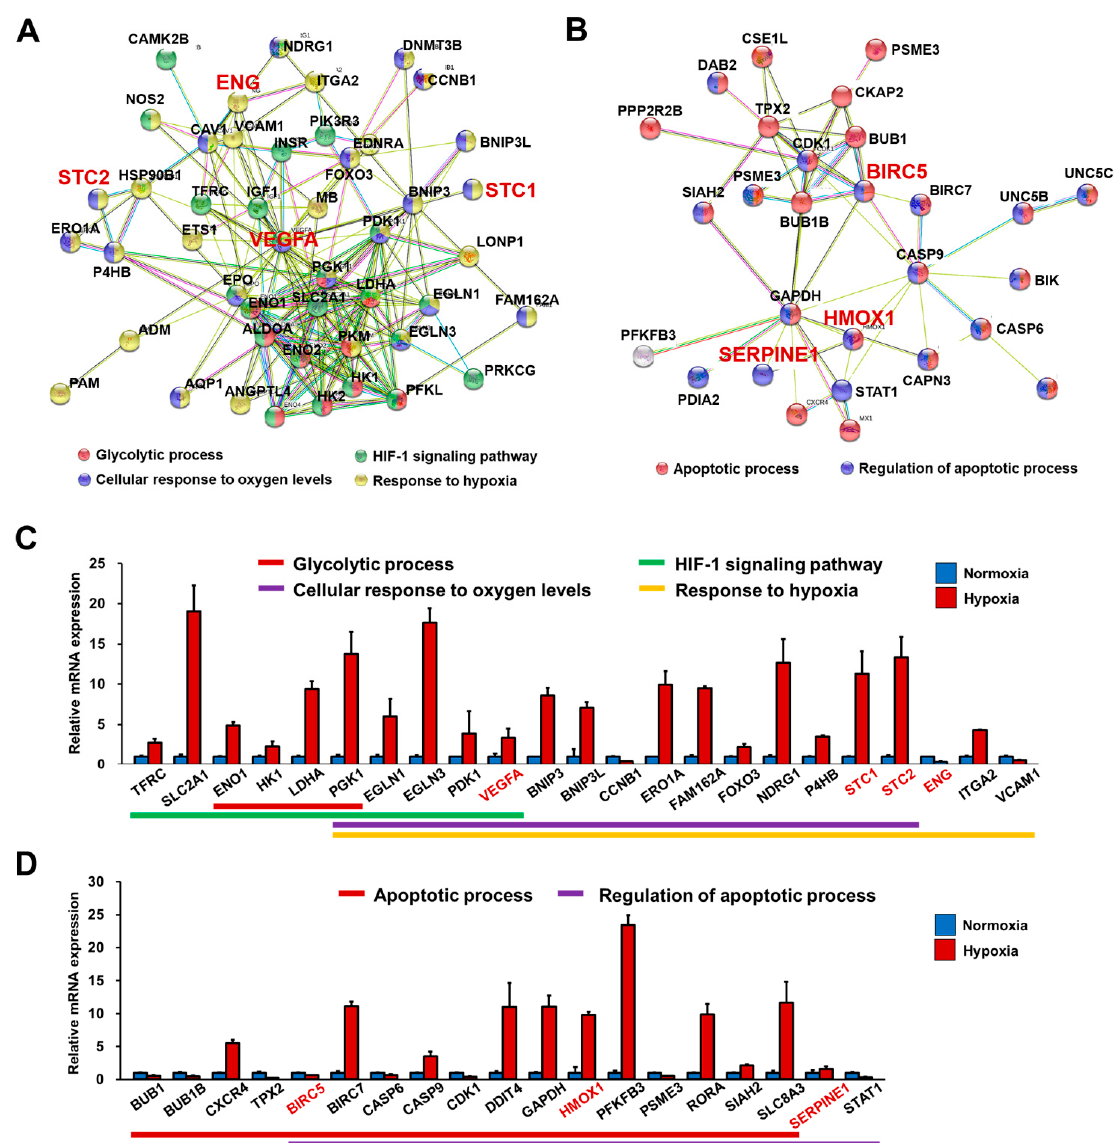
Figure 5. Transcriptome of FGF4+AA-treated BG01 hESC-CMs showing expression of hypoxia-responsive genes. Validation of hypoxia-responsive genes and potential cardiac biomarkers induced in FGF4+AA-treated hESC-CMs by qRT-PCR analysis. Protein–protein interaction networks among differentially expressed genes related to ( A ) glycolytic process, HIF- signaling pathway, cellular response to oxygen levels, and response to hypoxia, and ( B ) apoptotic process, and regulation of apoptotic process in BG01 hESC-CMs. Differentially expressed genes involved in ( C ) hypoxia-responses, and ( D ) apop- totic processes in BG01 hESC-CMs were evaluated using the same samples as those used for RNA-Seq using qRT-PCR. Data were normalized to expression of the housekeeping gene β -ACTIN. Values represent means ± SDs from triplicate data. Potential cardiac biomarkers in the diagnosis and prognosis of coronary artery diseases were indicated with red color in ( A – D ).